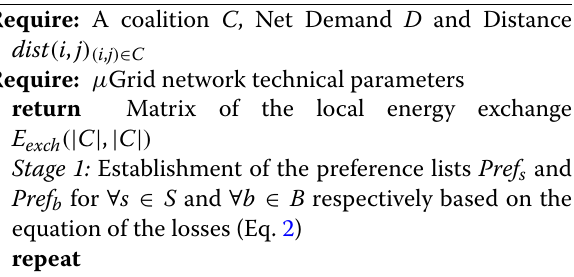
Algorithm 2 μ Grid Matching Game Table 1 Network